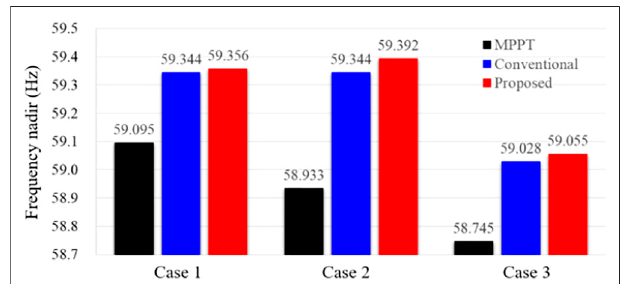
FIGURE 13 | Frequency nadirs for all cases.